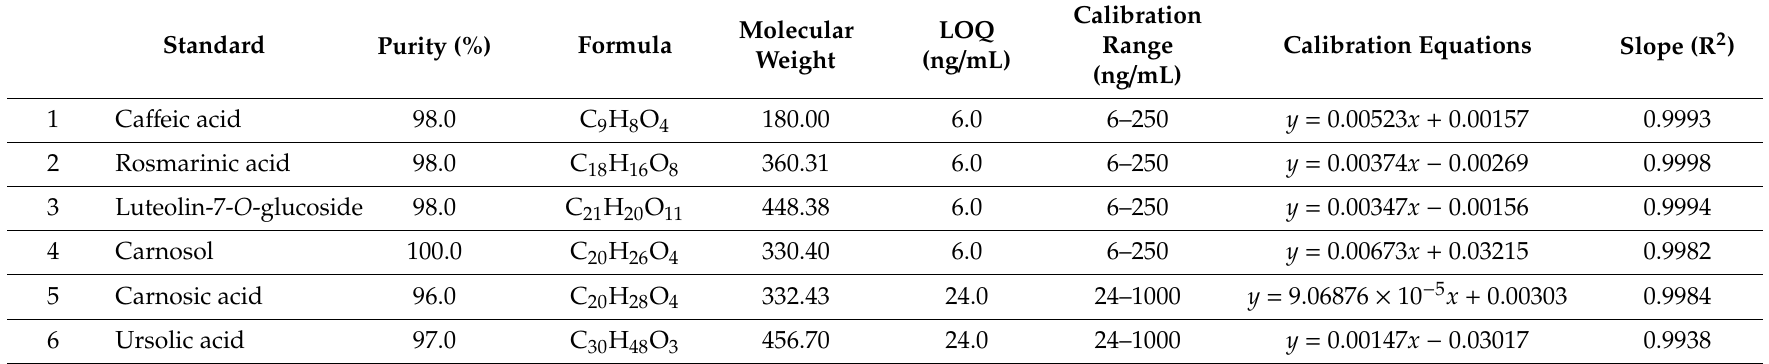
Table 5. Results of analysis of calibration curve and limits of